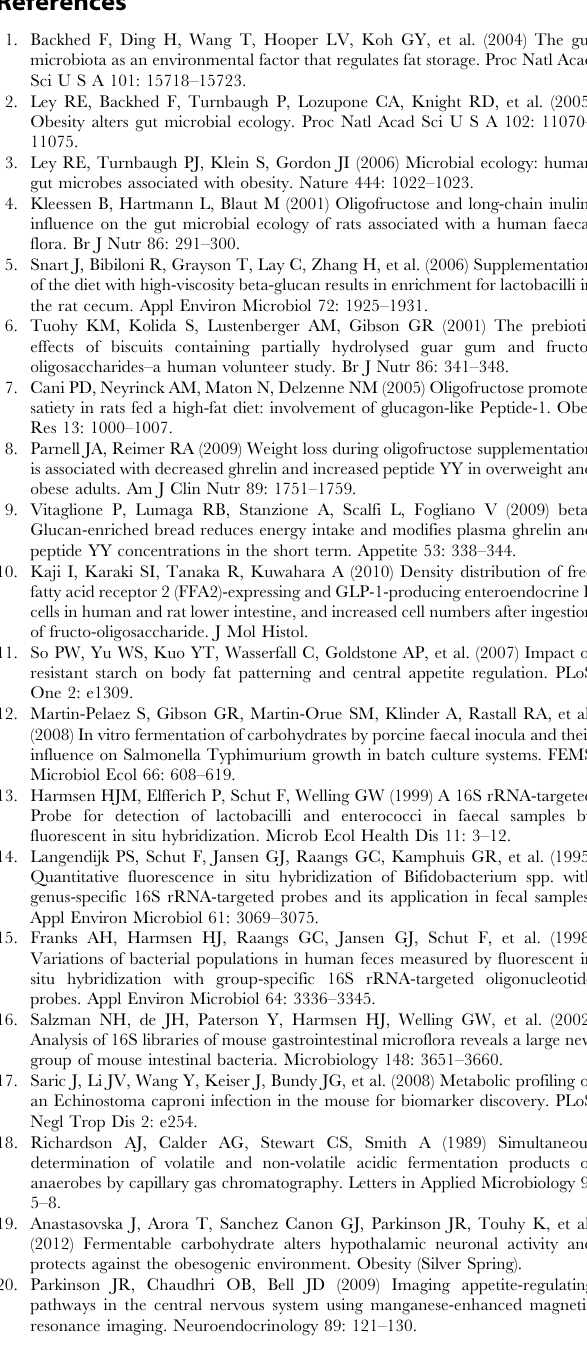
Figure S2 PCA scores plot of fecal metabolite profiles showing clear clustering patterns for HFD-C, HFD-BG and HFD-I groups of mice.